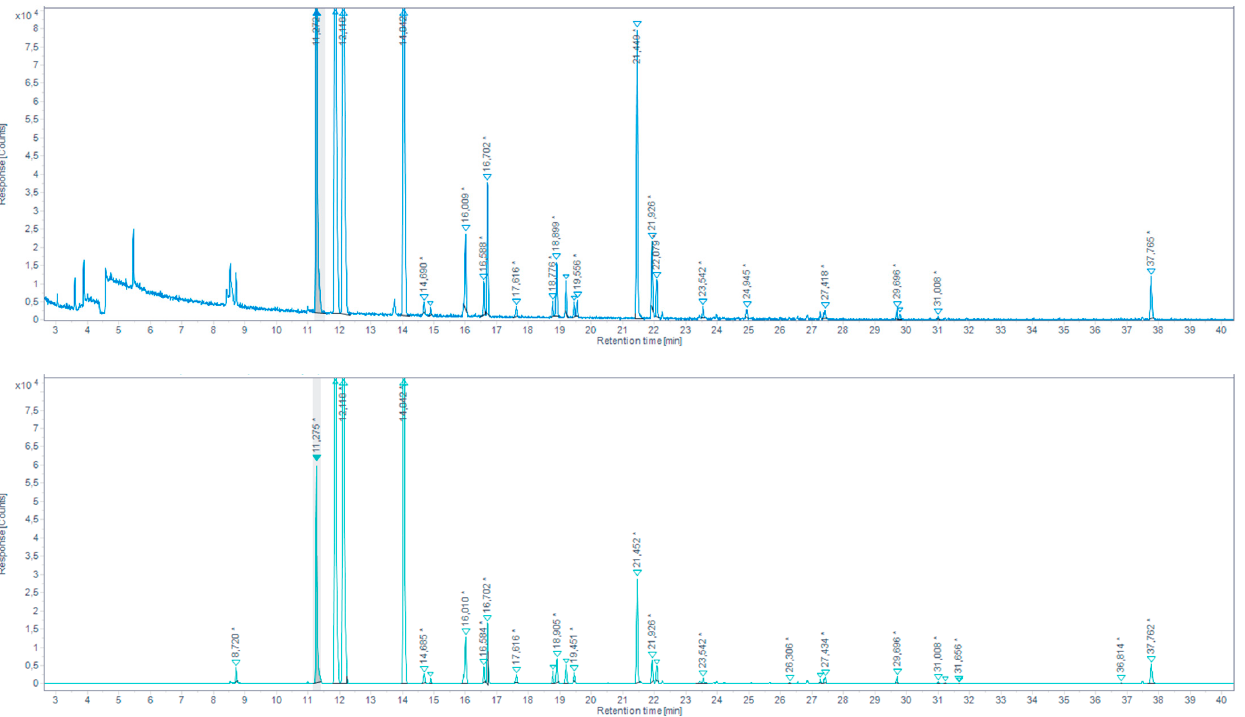
Figure 6. Total ion chromatogram (TIC) for the aqueous chicken sample extracted by SAFE and derivatized with PFBHA (up) and the extracted-ion chromatogram (EIC) 180.7–181.7 m/z (down) (* indicates that the peak has been manually integrated). Table 4. Identification of carbonyl compounds in overcooked chicken meat aqueous extract sample extracted by SAFE and derivatized with PFBHA based on RT, KRI, and fragmentation.